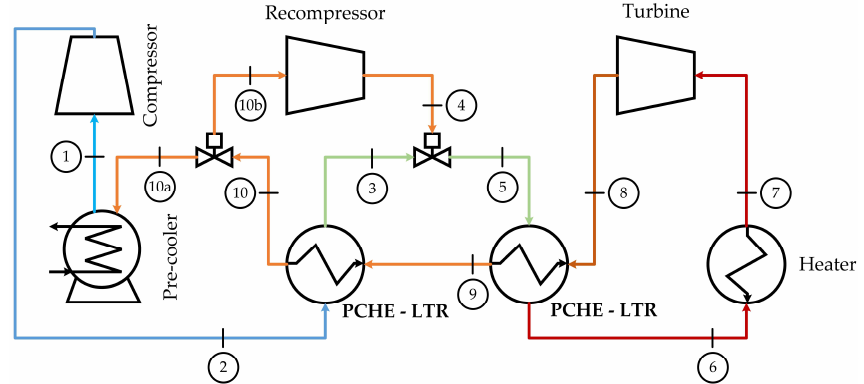
Figure 17. Schematic of the Brayton cycle of recompression supercritical carbon